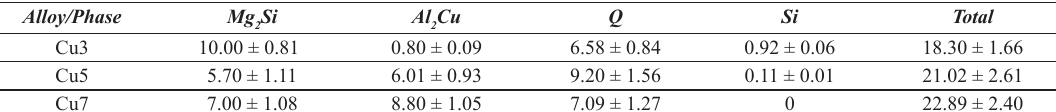
Table 2. Second phases percentage for the experimental alloys.